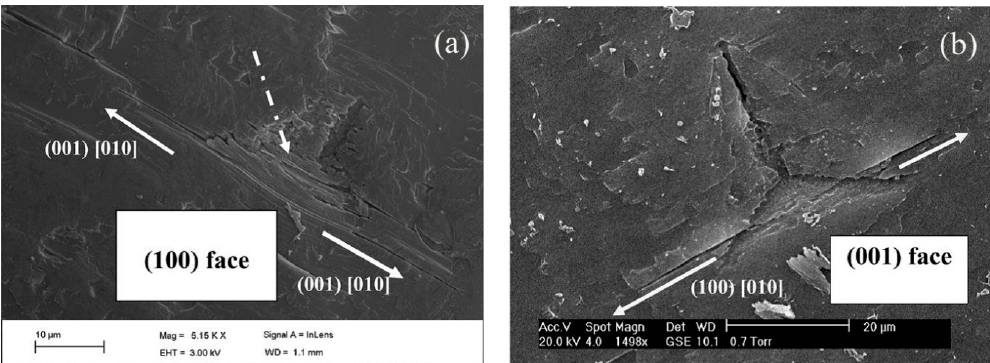
Figure 10. The scanning electron microscopic image of residual indent impression on aspirin ( a ) (100) and ( b ) (001) faces. A fracture is evident in the [010] direction. (Reproduced with permission from Elsevier, Reference 90).